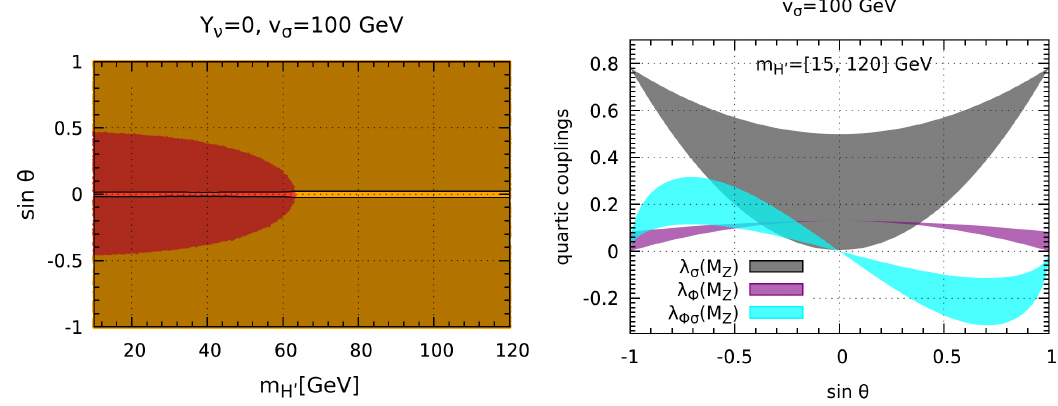
Figure 12 . Left panel: values of m H 0 and mixing angle θ leading to an unstable vacuum (in red), to a Landau pole or non-perturbative quartic couplings (in brown), at some energy scale below the Planck scale. We have fixed Y = 0 , v = 100 GeV and the heavy neutrino mass scale ν σ Λ = 10 TeV. The region between the black lines is allowed by LEP-LHC constraints. Right panel: initial electroweak values of λ , λ and λ as a function of sin θ . The band is due to the variation Φ σ Φ σ of the lighter scalar boson mass m [15 , 120] GeV H 0 ∈